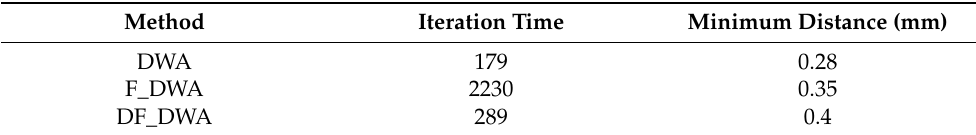
Table 7. The iteration time and minimum distance.